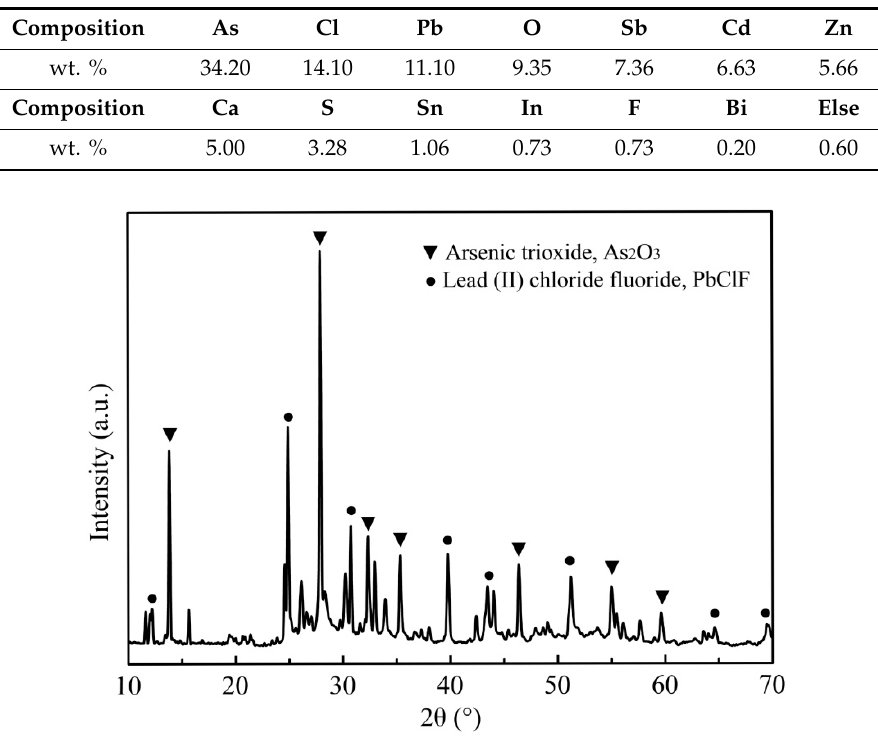
Figure 1. XRD pattern of the high-arsenic dust.